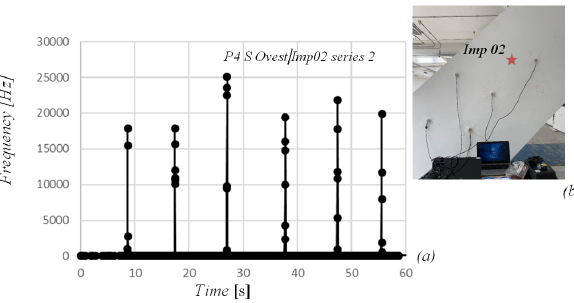
Figure 6: (a) Frequency vs time graph related to the acquisition of the acoustic signals due to the hammering in position imp02 (b)